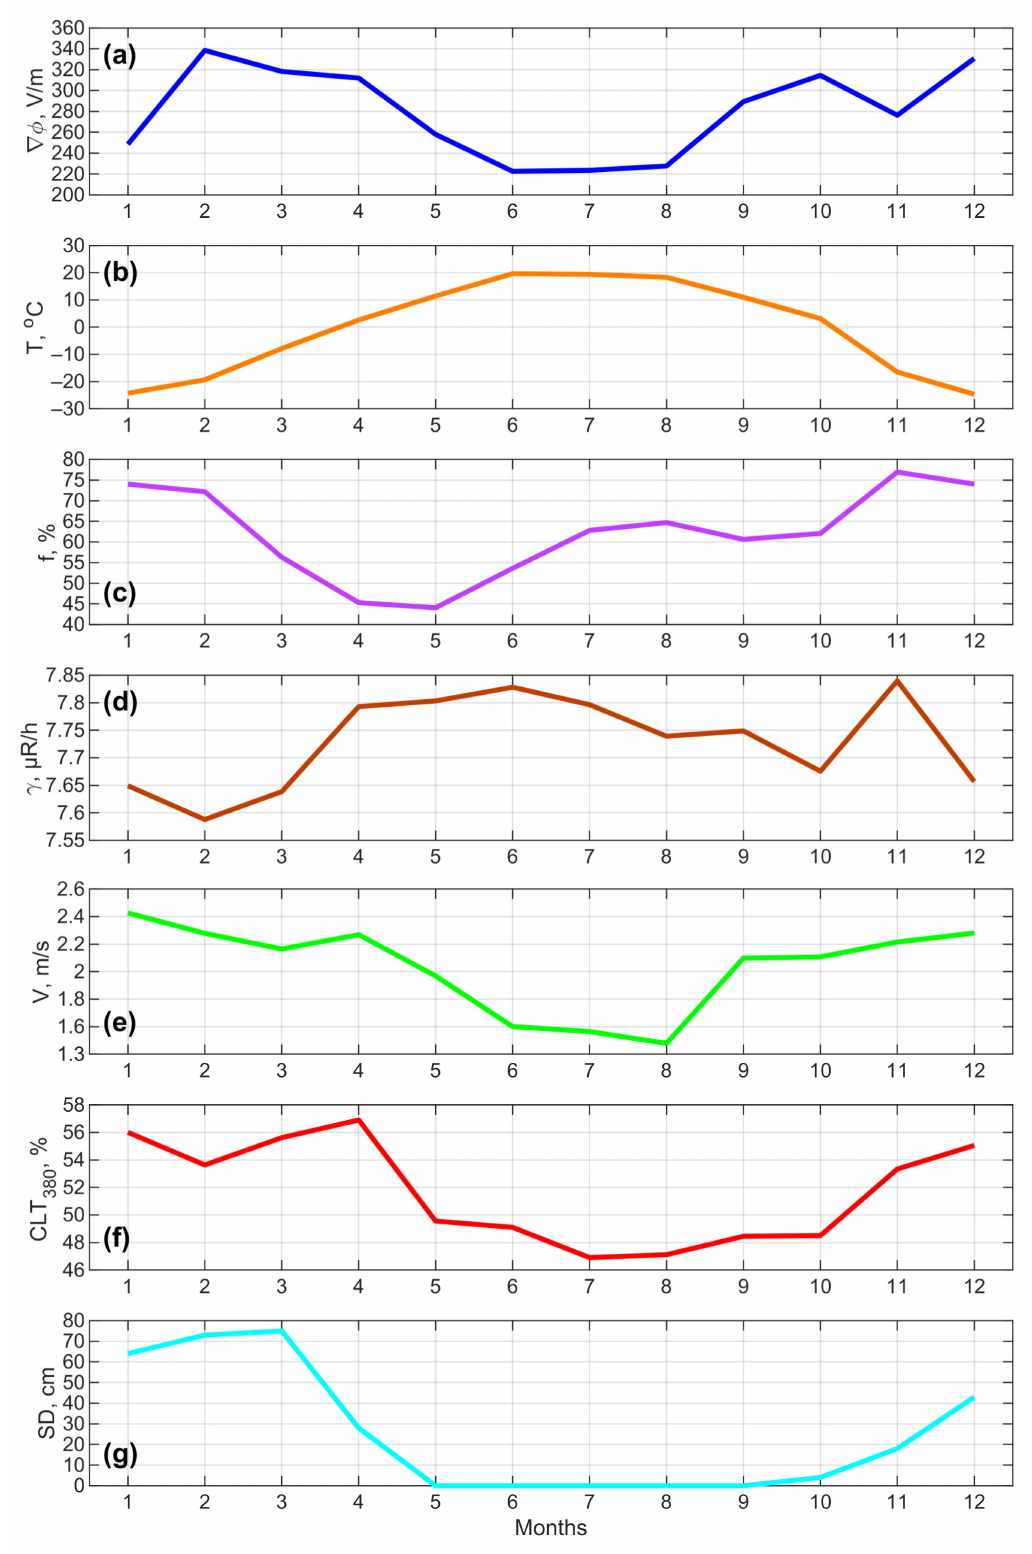
Figure A2. Variations in monthly averages of the potential gradient ( a ), air temperature ( b ), relative humidity ( c ), gamma radiation ( d ), wind speed ( e ), and atmospheric transparency at 380 nm ( f ) under fair-weather conditions in Tomsk according to data from the IMCES GO for 2006–2020, and monthly average snow depth ( g ) according to Tomsk weather